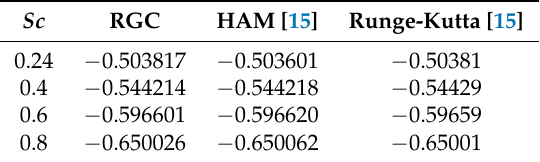
Table 4. Comparison of RGC, HAM and Runge-Kutta solution of C (cid:48) N = 0.8 and K =